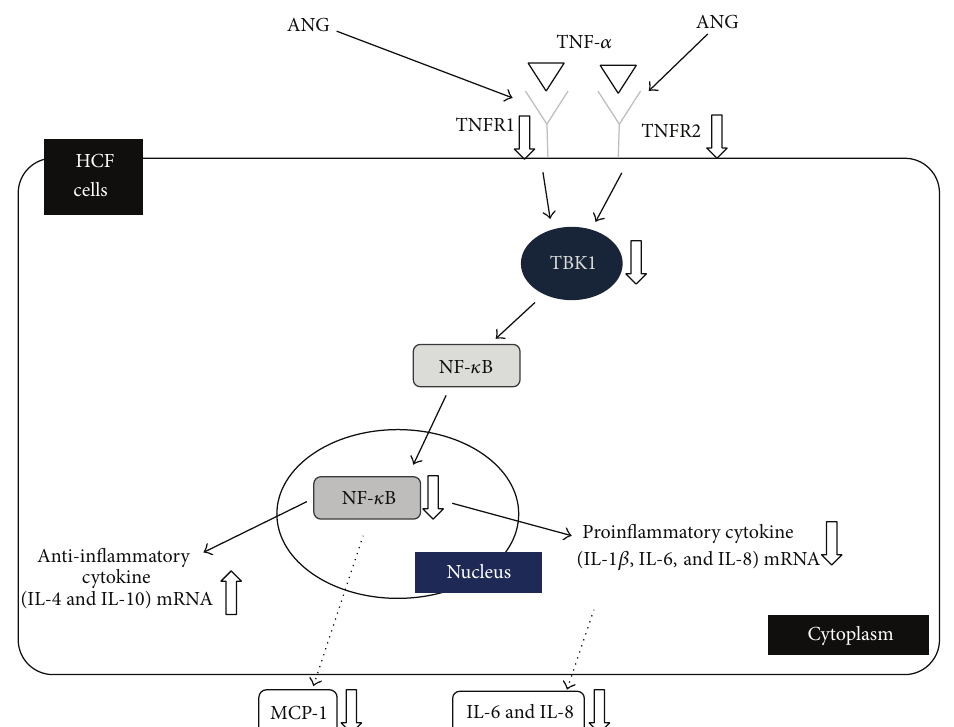
Figure6:SchematicmodelillustratingthesignalingpathwaybywhichANGsuppressestheinflammatoryresponseinvolvingTBK1-mediated NF- 𝜅 B nuclear translocation in HCFs inflamed by TNF- 𝛼 . ANG reduces the mRNA expression of proinflammatory cytokines (IL-1 𝛽 , -6, and -8) and enhances the mRNA expression of anti-inflammatory cytokines (IL-4 and -10). ANG also inhibits NF- 𝜅 B nuclear translocation through a reduction in TNFR1 and 2 mRNA expression and TBK1 production. The cascade underlying the effect of ANG results in a